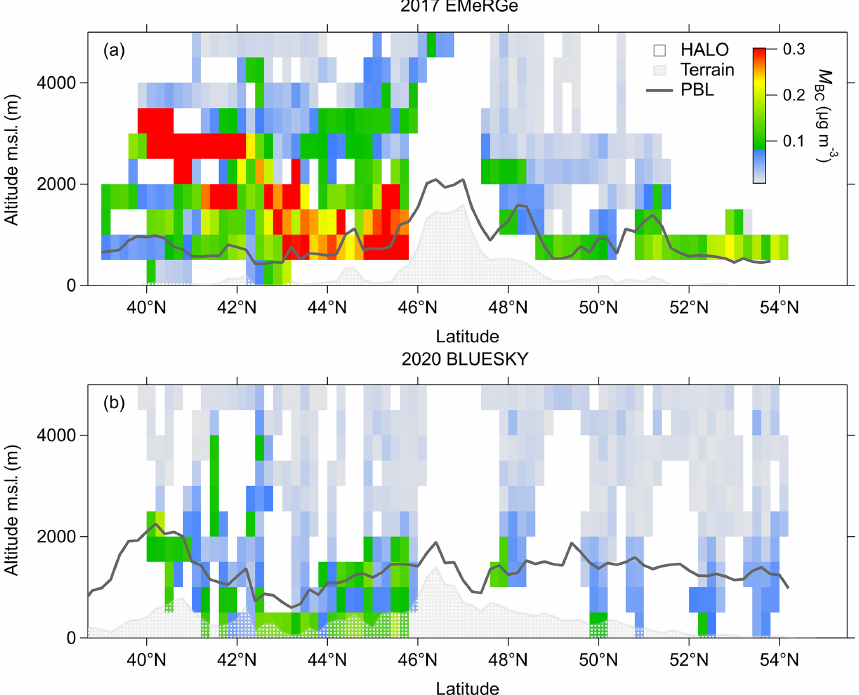
Figure 6. (a) Cross section of M BC for 2017 EMeRGeEU measurements. Arithmetic mean for all data falling into a grid point of 0.2 ◦ latitude and 500m altitude. The colour scale ranges from 0 to 0.3µgm − 3 . Means exceeding this range are shown in red. Panel (b) is as (a) but for the 2020 BLUESKY measurements. The grey shading is the mean terrain height below flight track, and the grey solid line shows the planetary boundary layer height below flight track (details in Sect. S1 in the Supplement).